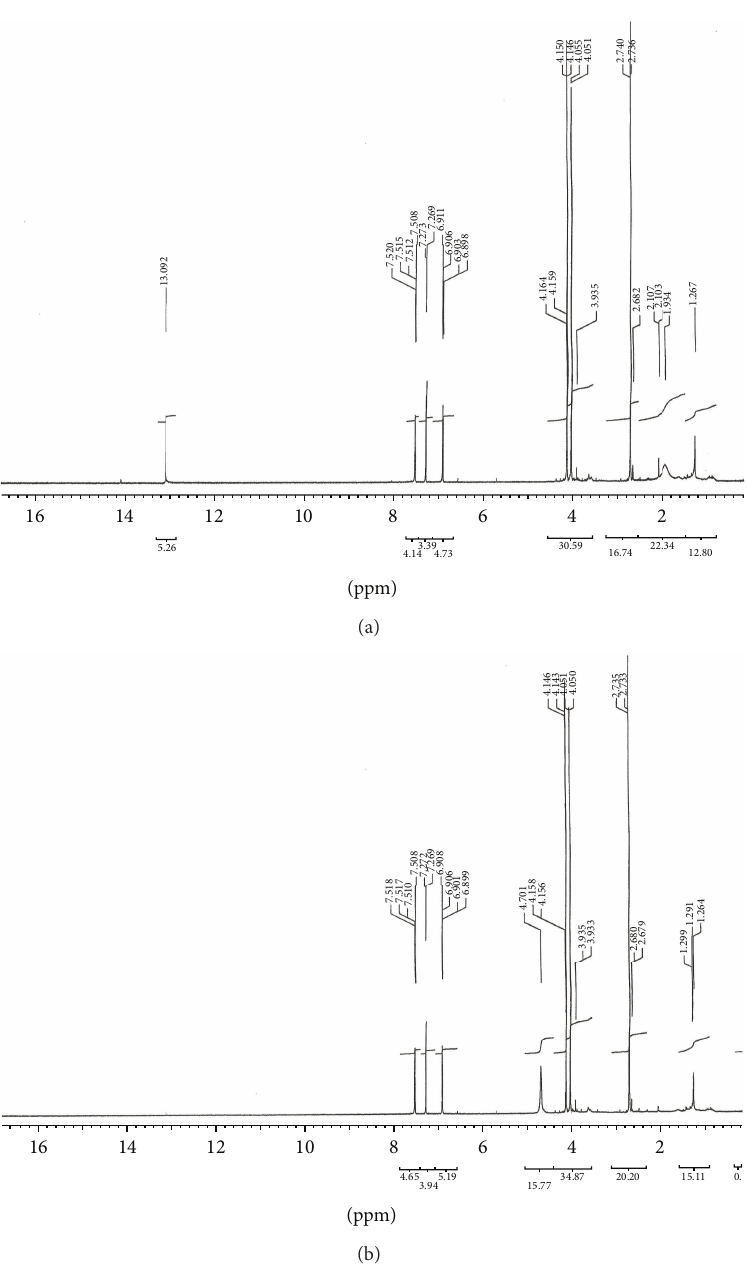
Figure 2: (a) 1 H-NMR spectra of EEDB resin in CDCL 3 -H. (b) 1 H-NMR spectra of EEDB resin in DMSO-D 2 O.